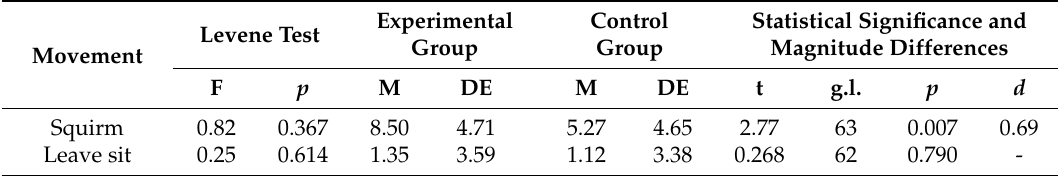
Table 4. Average differences in movement registered by observers in experimental group and control group.